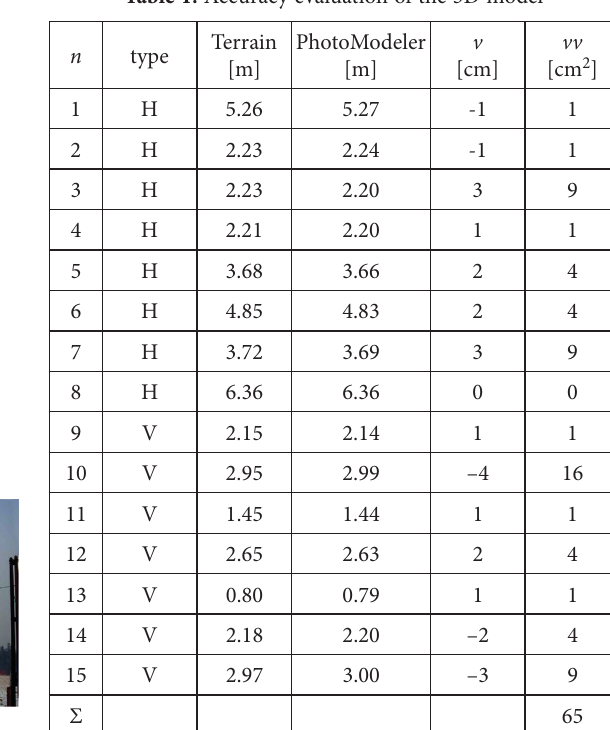
Fig. 10. 3D model of the chapel connected to photographs taken